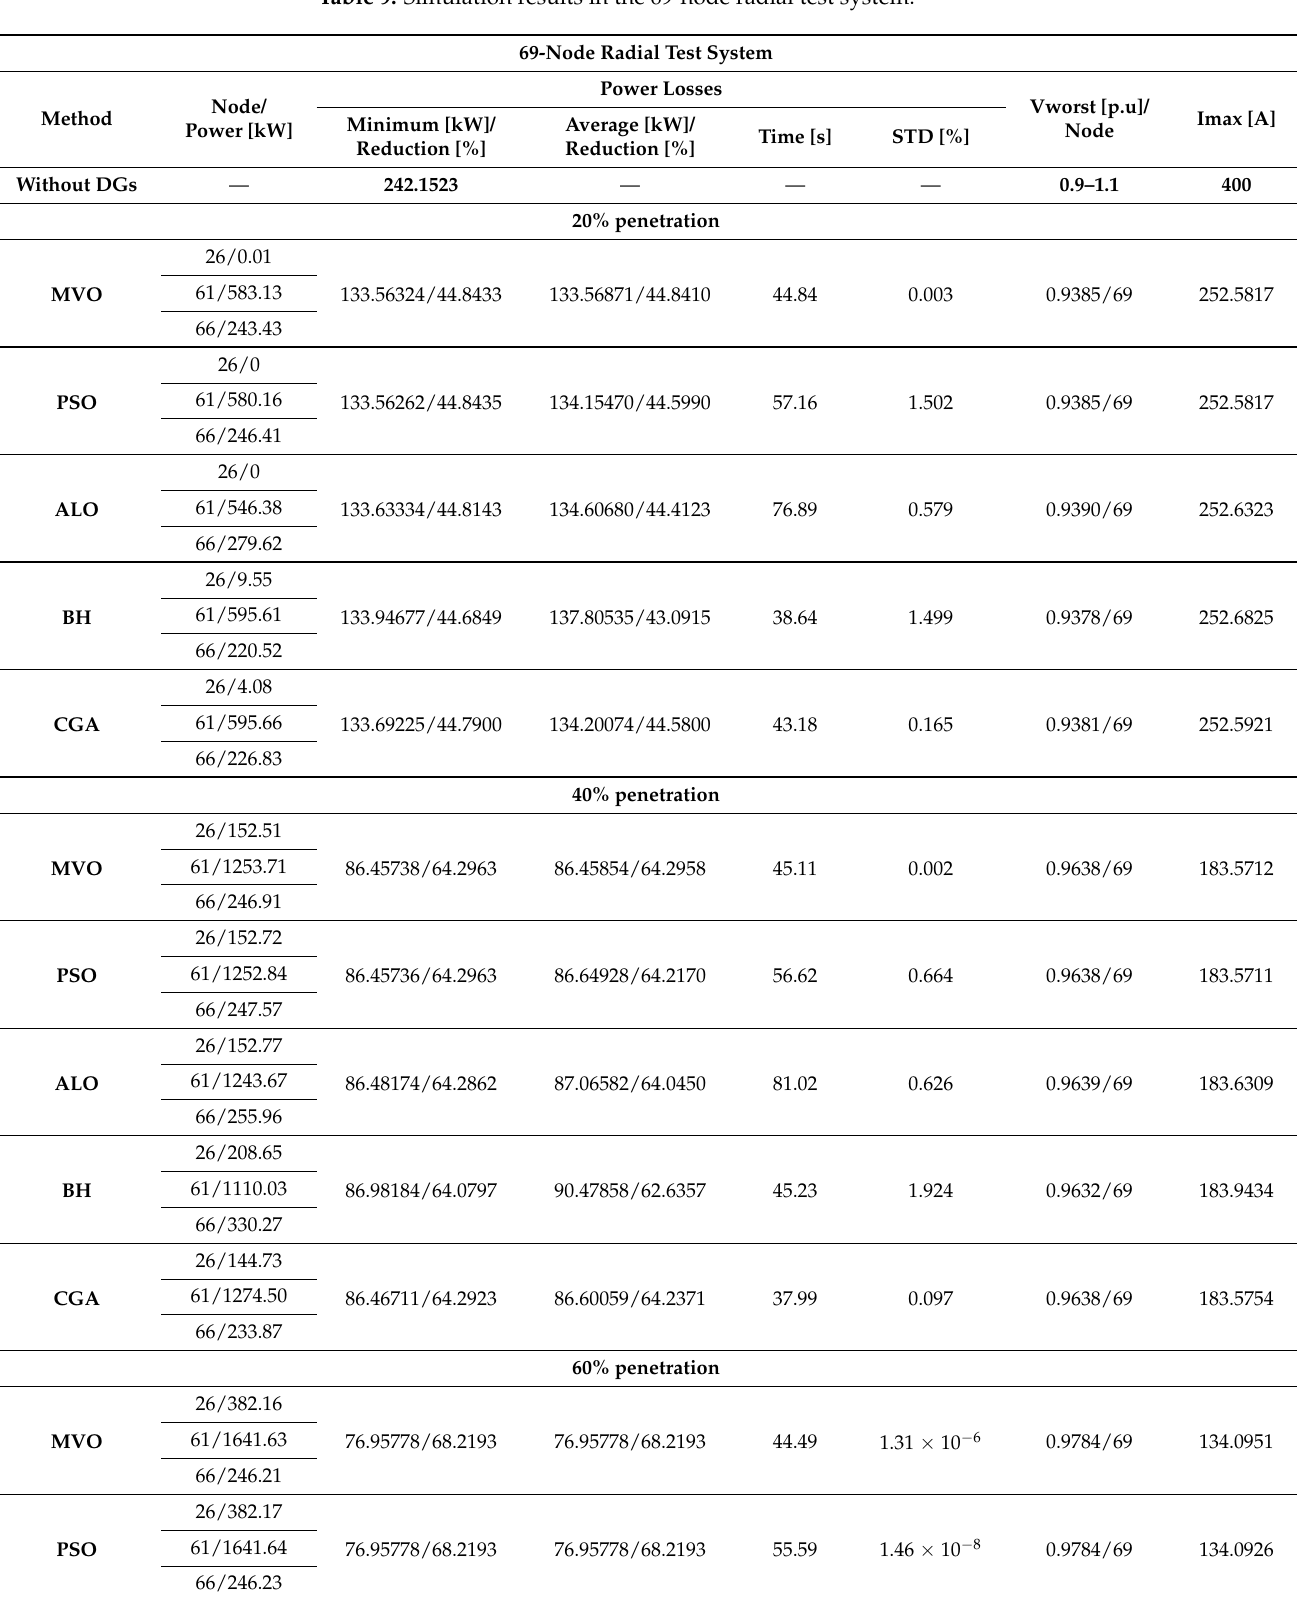
Table 9. Simulation results in the 69-node radial test